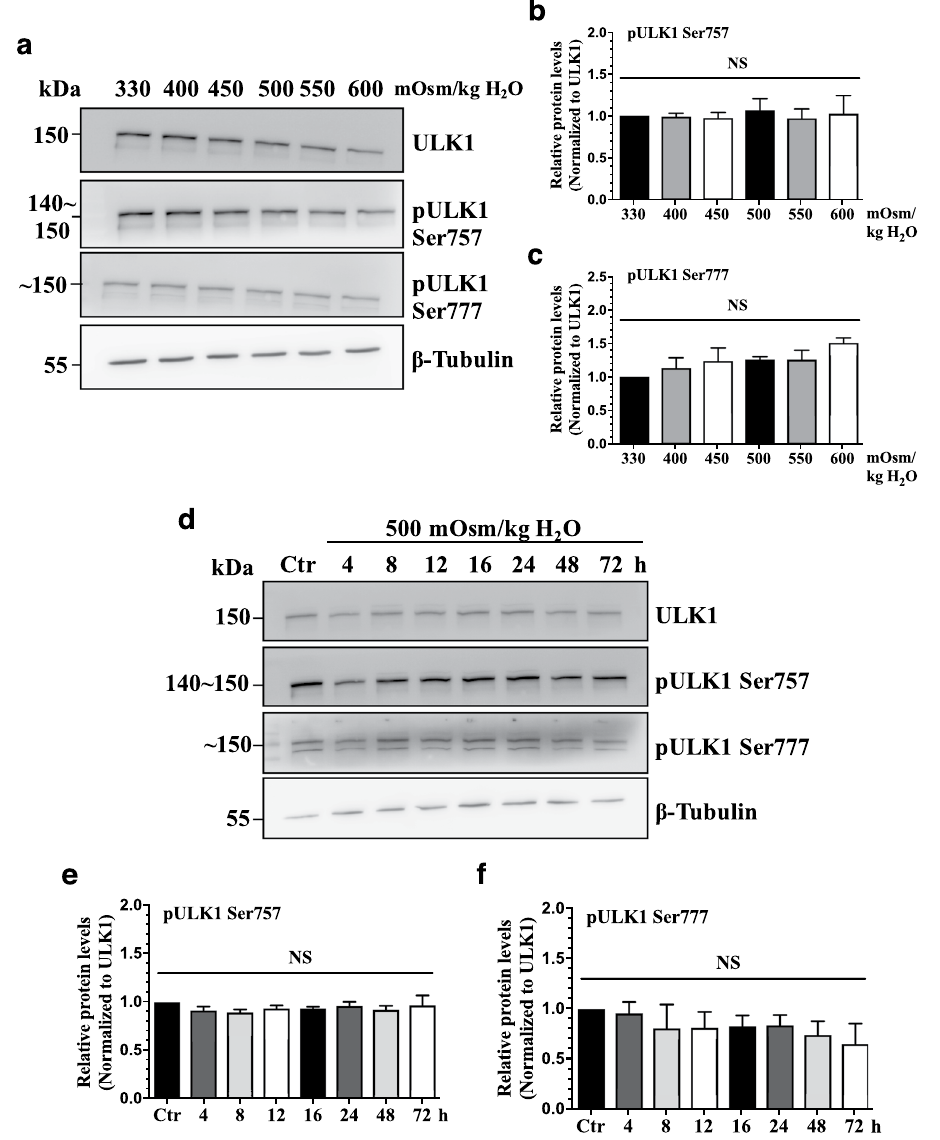
Figure 7. Hyperosmolarity does not activate autophagy through MTOR-AMPK-ULK1 axis in NP cells. ( a ) Western blot analysis of NP cells treated with increasing osmolarity (330–600 mOsm/kg H 2 O) showed that the levels of pULK1 Ser757 and pULK1 Ser777 were not affected by hyperosmolarity. ( b , c ) Densitometric analyses of multiple Western blots represented in ( a ) confirmed lack of effect on ULK1 phosphorylaiton at Ser757 and Ser777 by hyperosmolarity. ( d ) Western blot analysis of NP cells cultured in hyperosmotic media for increasing lengths of time demonstrated that phosphorylation of ULK1 at both Ser757 and Ser777 by MTOR and AMPK respectively was not affected by hyperosmolarity till 72 h. (E, F) Denstiometric analyses of multiple Western blots represented in ( d ). Bars represent mean ± SEM (n = 3). One-way ANOVA with Sidak’s multiple comparisons test was used to determine statistical significance. NS, non-significant. Western blot images were cropped and acquired under same experimental conditions. See Supplementary Fig. S1 for examples of uncropped